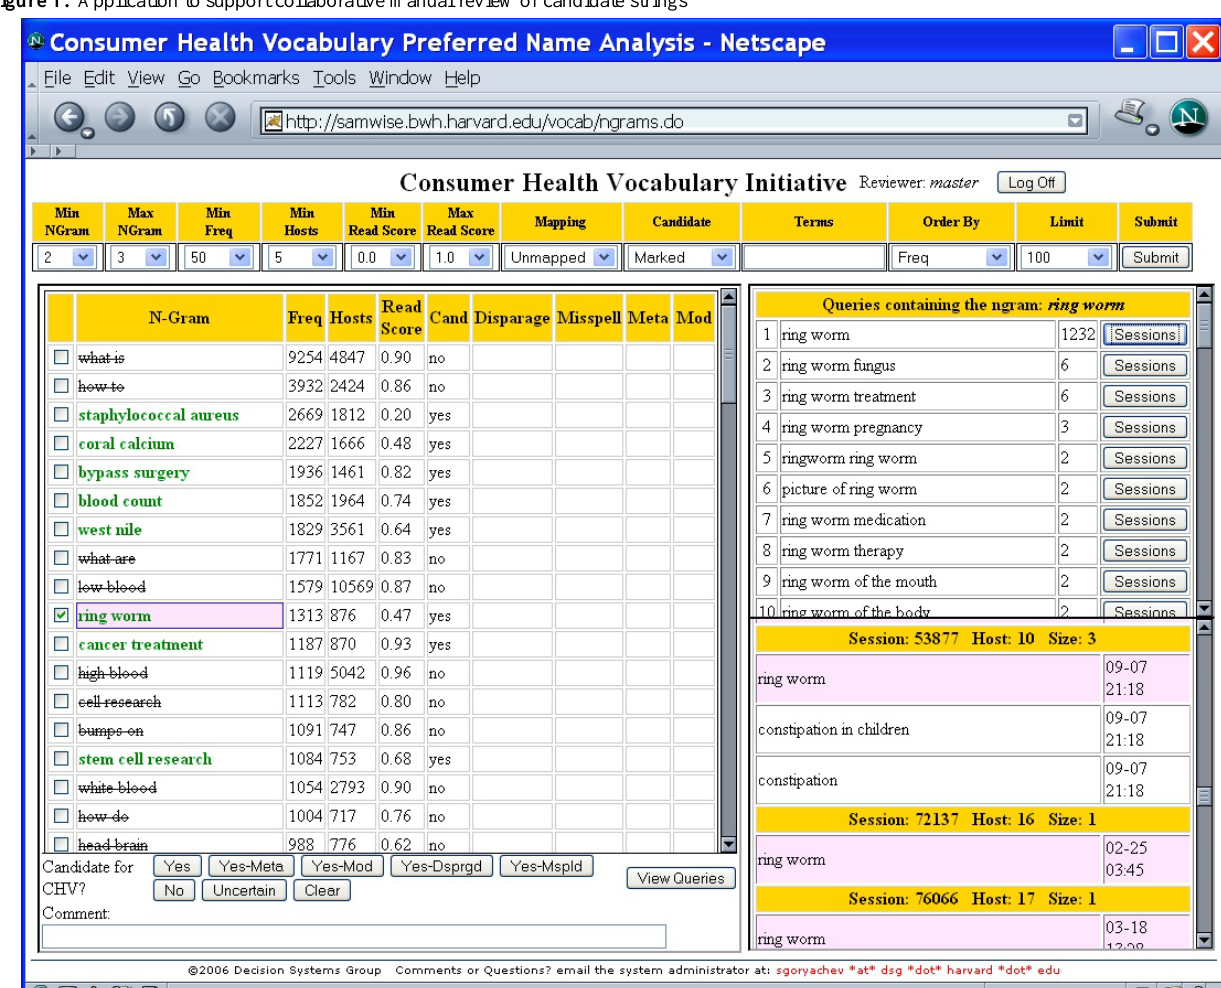
Figure 1. Application to support collaborative manual review of candidate